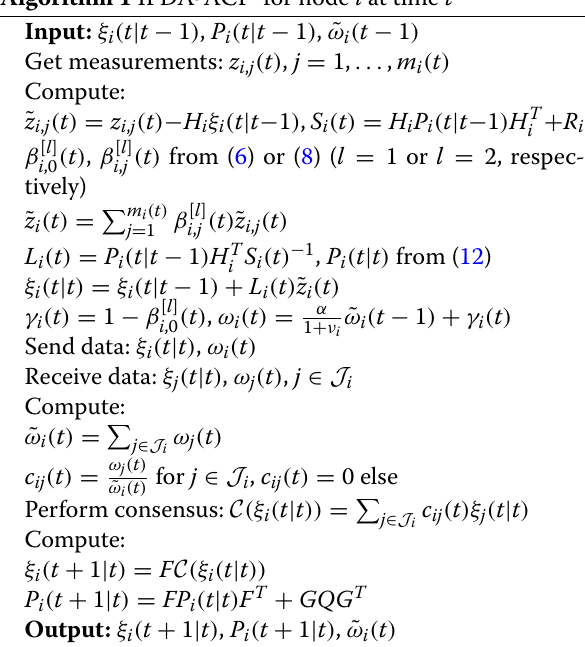
Algorithm 1 IPDA-ACF l for node i at time